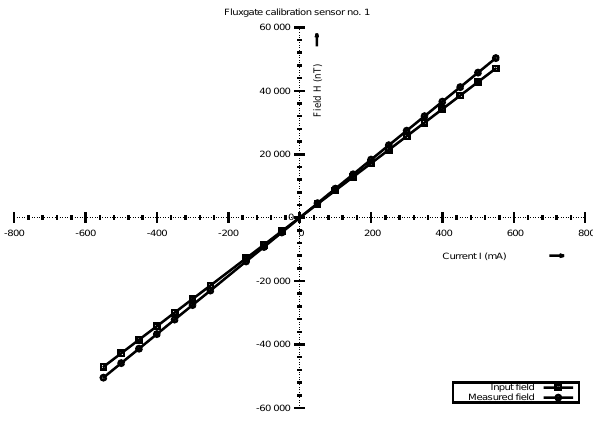
Figure 9. Fluxgate calibration using a h coil (sensor no. 1).